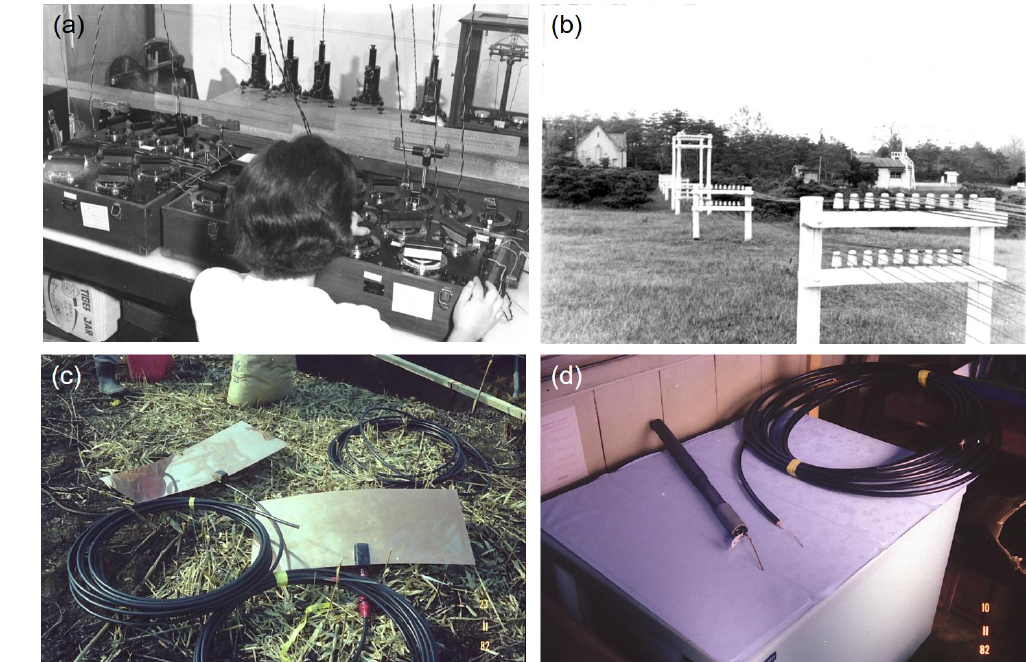
Figure 14. (a) A reflecting galvanometer and a voltmeter with a 10 k(cid:127) resistor, (b) cables, (c) a pair of copper plate electrodes and (d) a carbon rod electrode (photo supplied by Kakioka Magnetic Observatory).